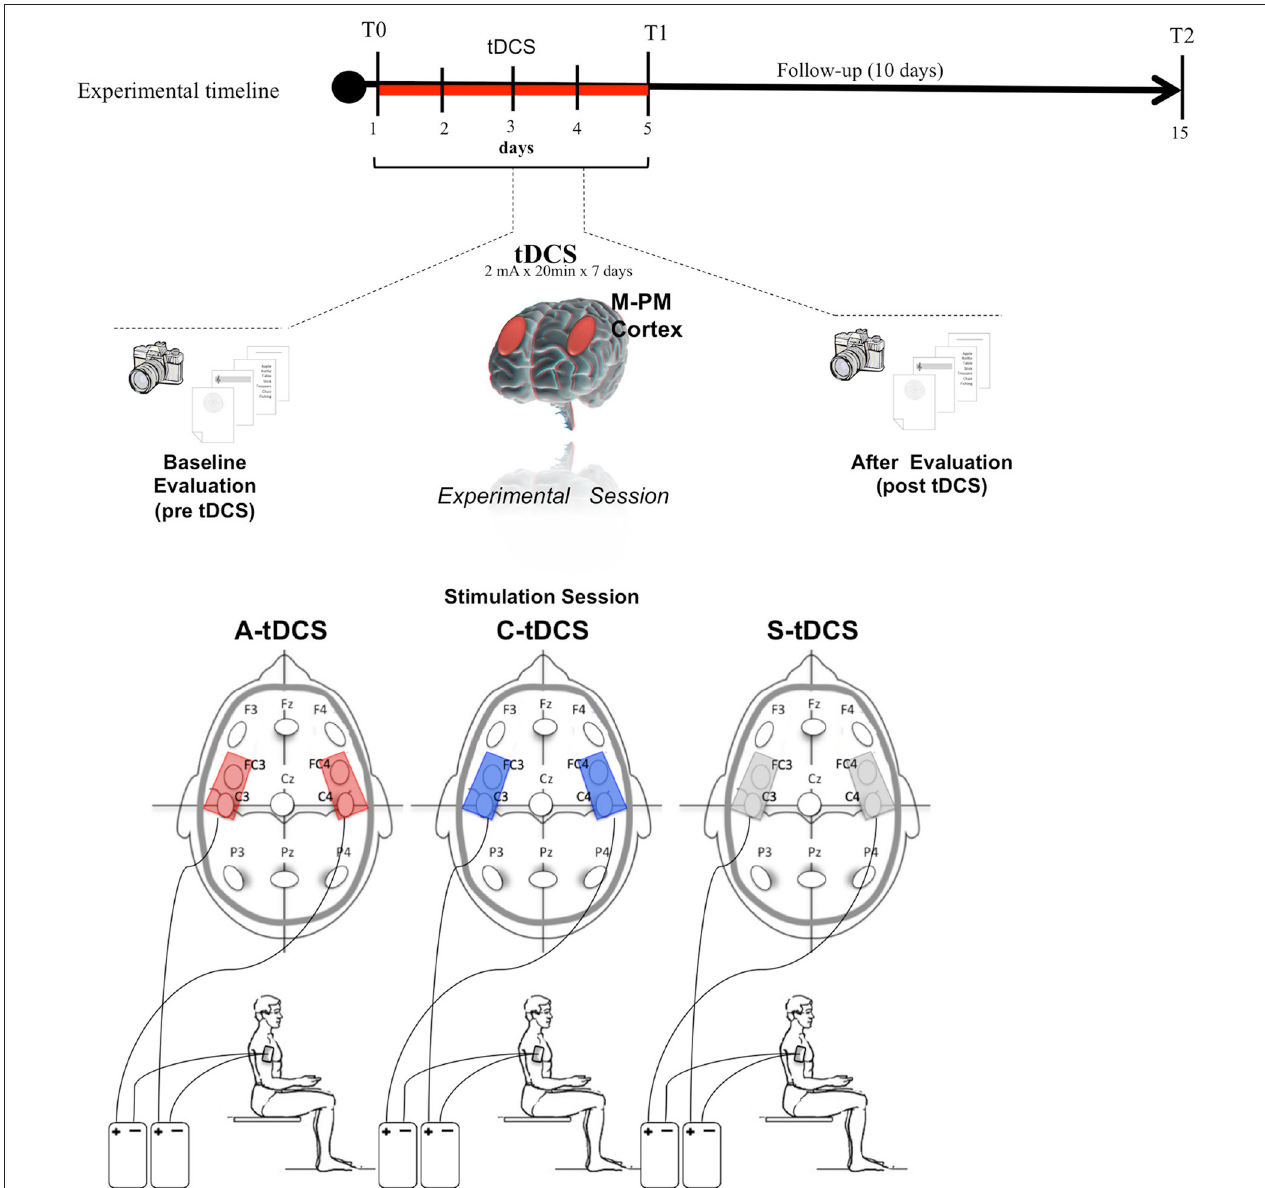
FIGURE 1 | Transcranial Direct Current Stimulation (tDCS) experimental protocol. tDCS was applied bilaterally over the scalp on the motor-premotor cortex (M-PM) for 5 consecutive days. Patients were assessed in the first (T0) and the last day (T1) and after 10 days from ended tDCS (T2).